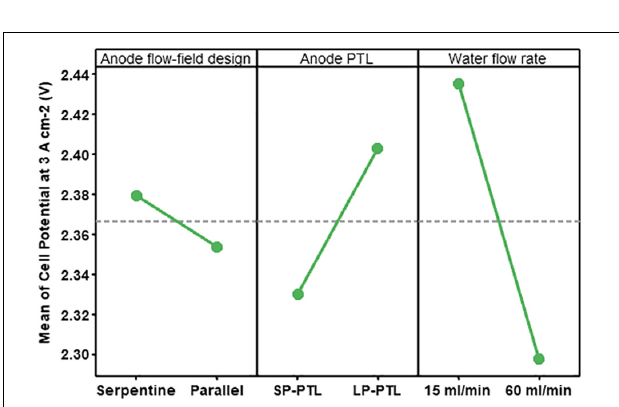
FIGURE 6 | Effects of factor A (anode flow-field design, B (anode PTL), and C (water flow rate) on the cell performance at 80 ◦ C and ambient pressure.